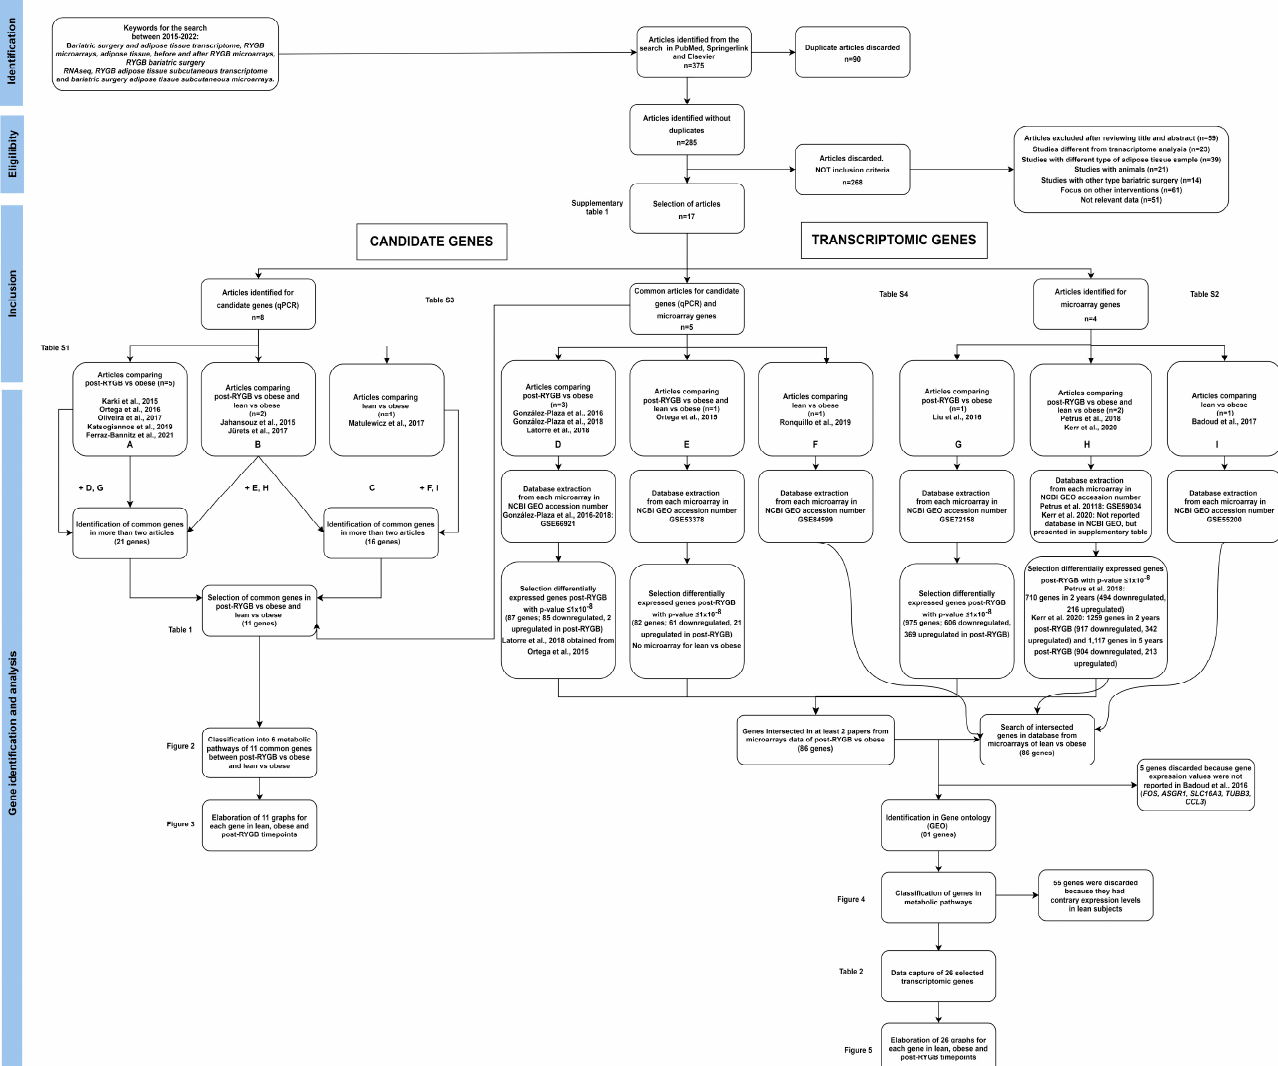
Figure 1. Systematic review flowchart . Identification, eligibility, inclusion, gene identification and analysis, using PRISMA (Preferred Reporting Items for Systematic Reviews and Meta-Analyses).